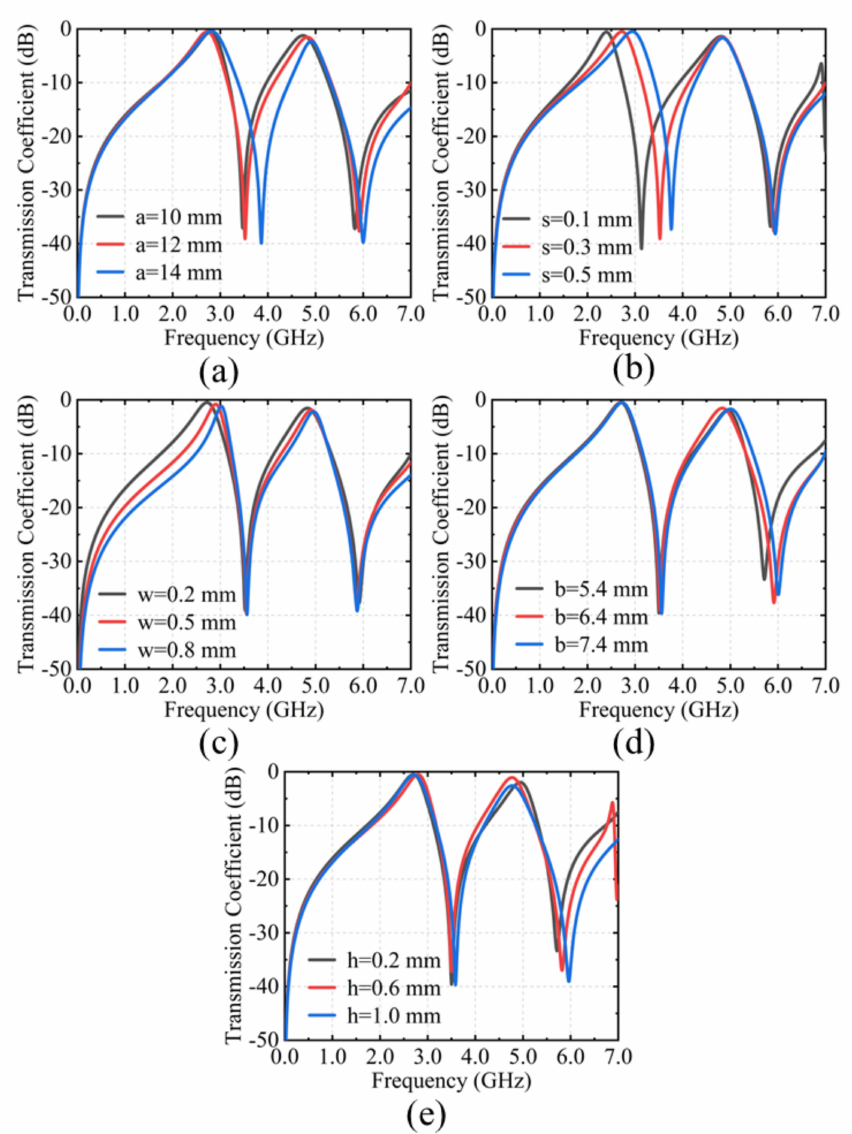
Figure 5. Parametric analysis by CST simulation. ( a ) The outside lengths of the split square ring on the top layer. ( b ) The width between two adjacent unit cells on the top layer. ( c ) The width of the metal grid on the middle layer. ( d ) The outside lengths of the split square ring on the bottom layer. ( e ) The thickness of the